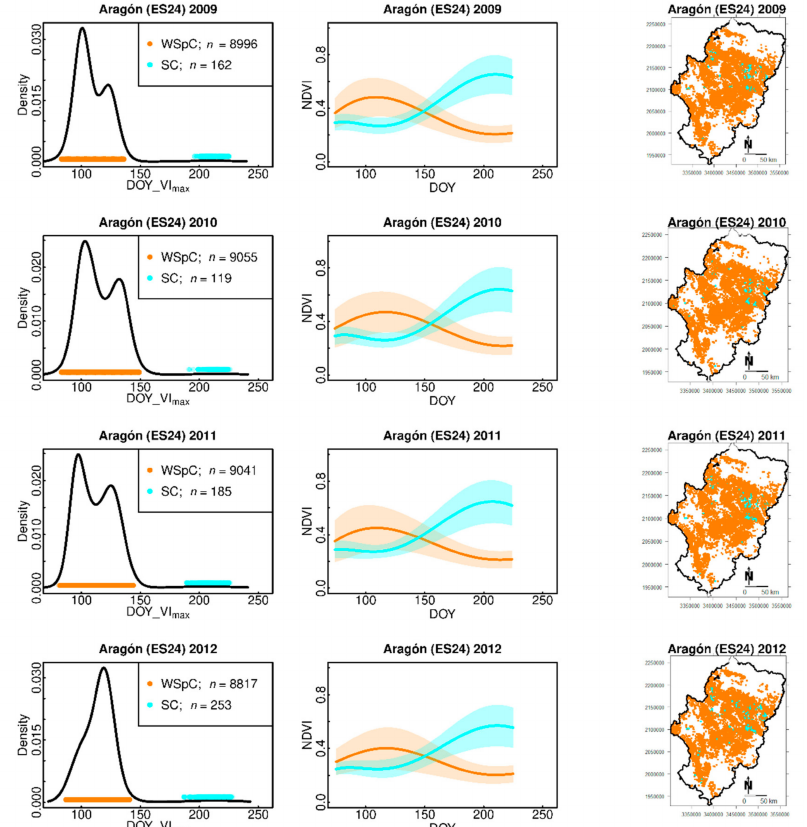
Figure 5. Probability density function of DOY_VImax (first column), NDVI timeseries (2nd column), and geographic distribution (3rd column) of the two crop group’s pure pixels for the region Arag ó n (Spain) from 2009–2012 (by row). Winter / spring crops (WSpCs, orange), summer crops (SCss, cyan). The timeseries depicts mean run ± 1